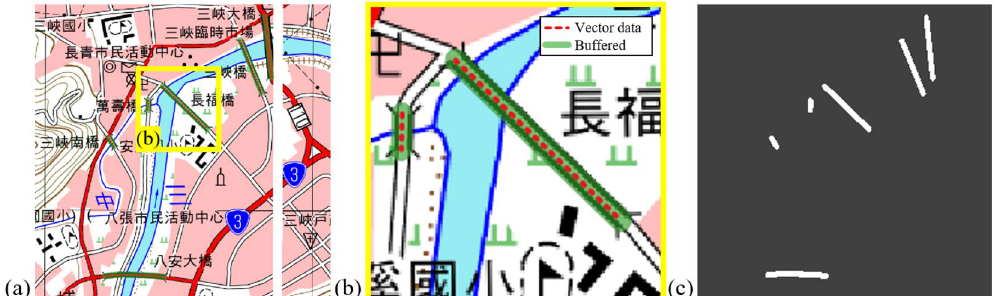
Figure 6. Converting the NLSC open vector data of bridge annotations into masks of the corresponding map tiles. ( a ) shows an example map tile of the labeling from the buffer operation , which generates buffers around points, lines, and polygons within a given distance. ( b ) shows a close-up of ( a ), where the vector data of bridges is drawn in red dotted lines, and the corresponding buffering regions are drawn in green strokes. ( c ) shows the extracted bridge masks of ( a ). † The maps in this figure are provided by Taiwan Historical Maps System (https:// gis. sinica. edu. tw/ tiles erver/) with permission.